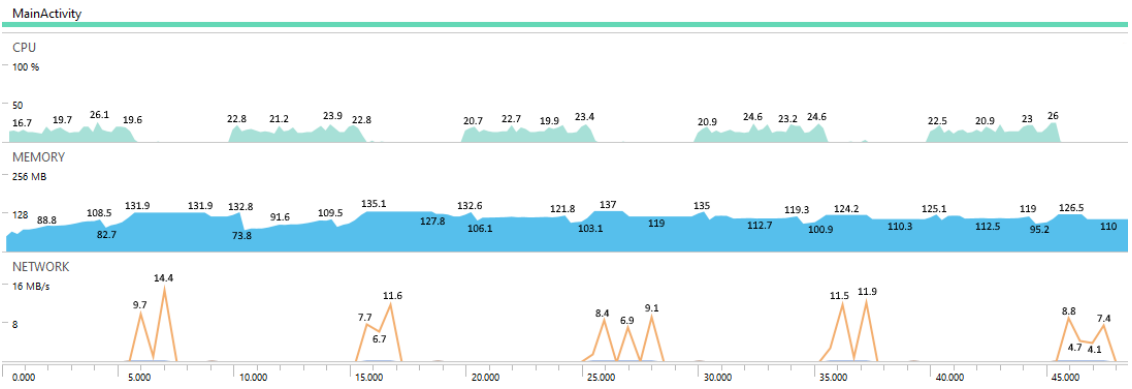
Figure 10. Multiple 7.5 MB file uploads.